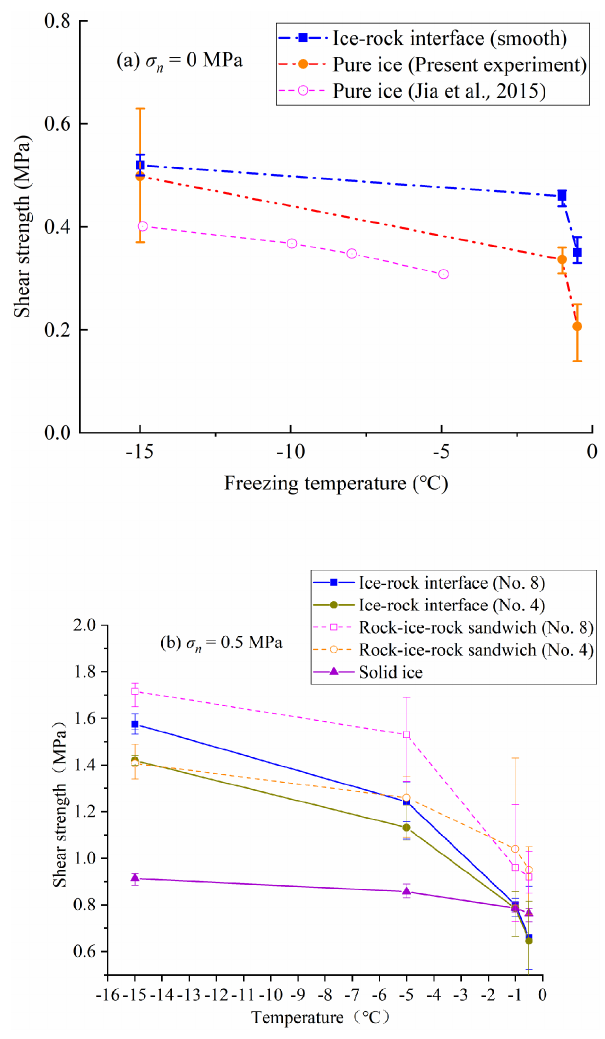
Figure 21. Influence of freezing temperature on the direct shear strength of ice and ice-filled joints. Experimental condition: v = 0.2mmmin − 1